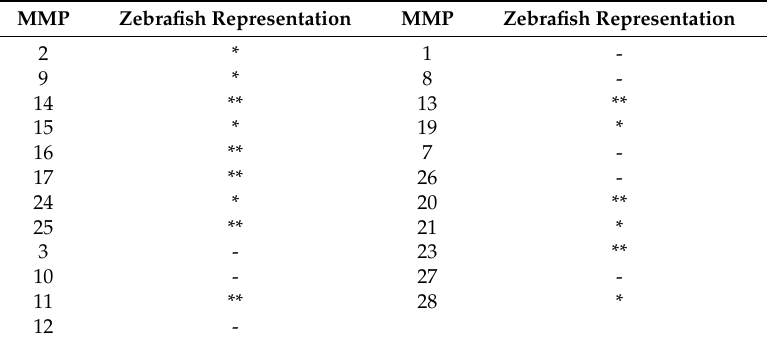
Table 1. Matrix metalloproteinase (MMP) representation in zebrafish. The MMP family of proteases are unevenly represented in zebrafish, adapted from [105]. A single asterisk indicates one copy present in zebrafish, double asterisk indicates duplicates and dash indicates